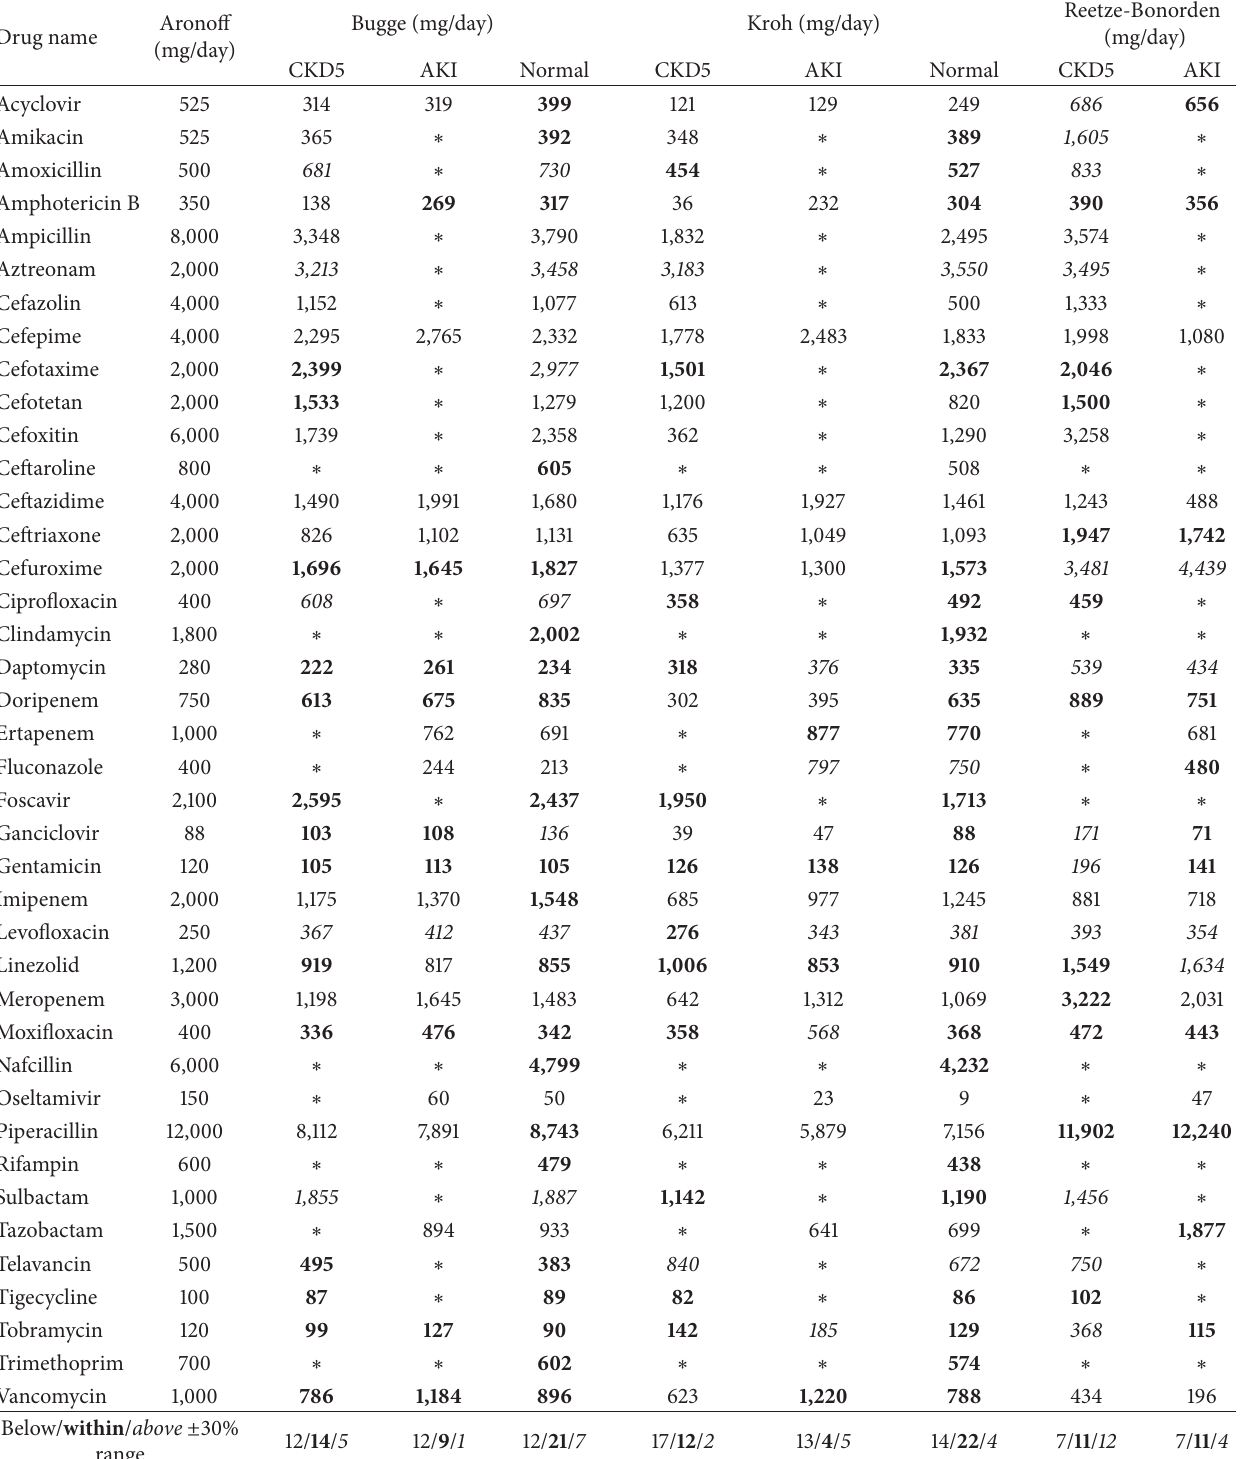
Table 2: Antimicrobial dose recommendations for a theoretical 70 kg patient receiving CRRT at an effluent rate of 33.3 mL/min. Doses recommended in Aronoff et al. guidelines and calculated with the Bugge [4], Kroh [5], and Reetze-Bonorden [6] equations utilizing CKD5, AKI, or normal patient data are shown below. Normal text indicates a dose ≥ 30% less than the Aronoff dose, bold text indicates a dose ± 30% of the Aronoff dose, and italicized text indicates a dose ≥ 30% greater than the Aronoff dose. The number of doses below, within, or above this range is reported in the final row. An asterisk ( ∗ ) denotes insufficient published pharmacokinetic data to allow dose